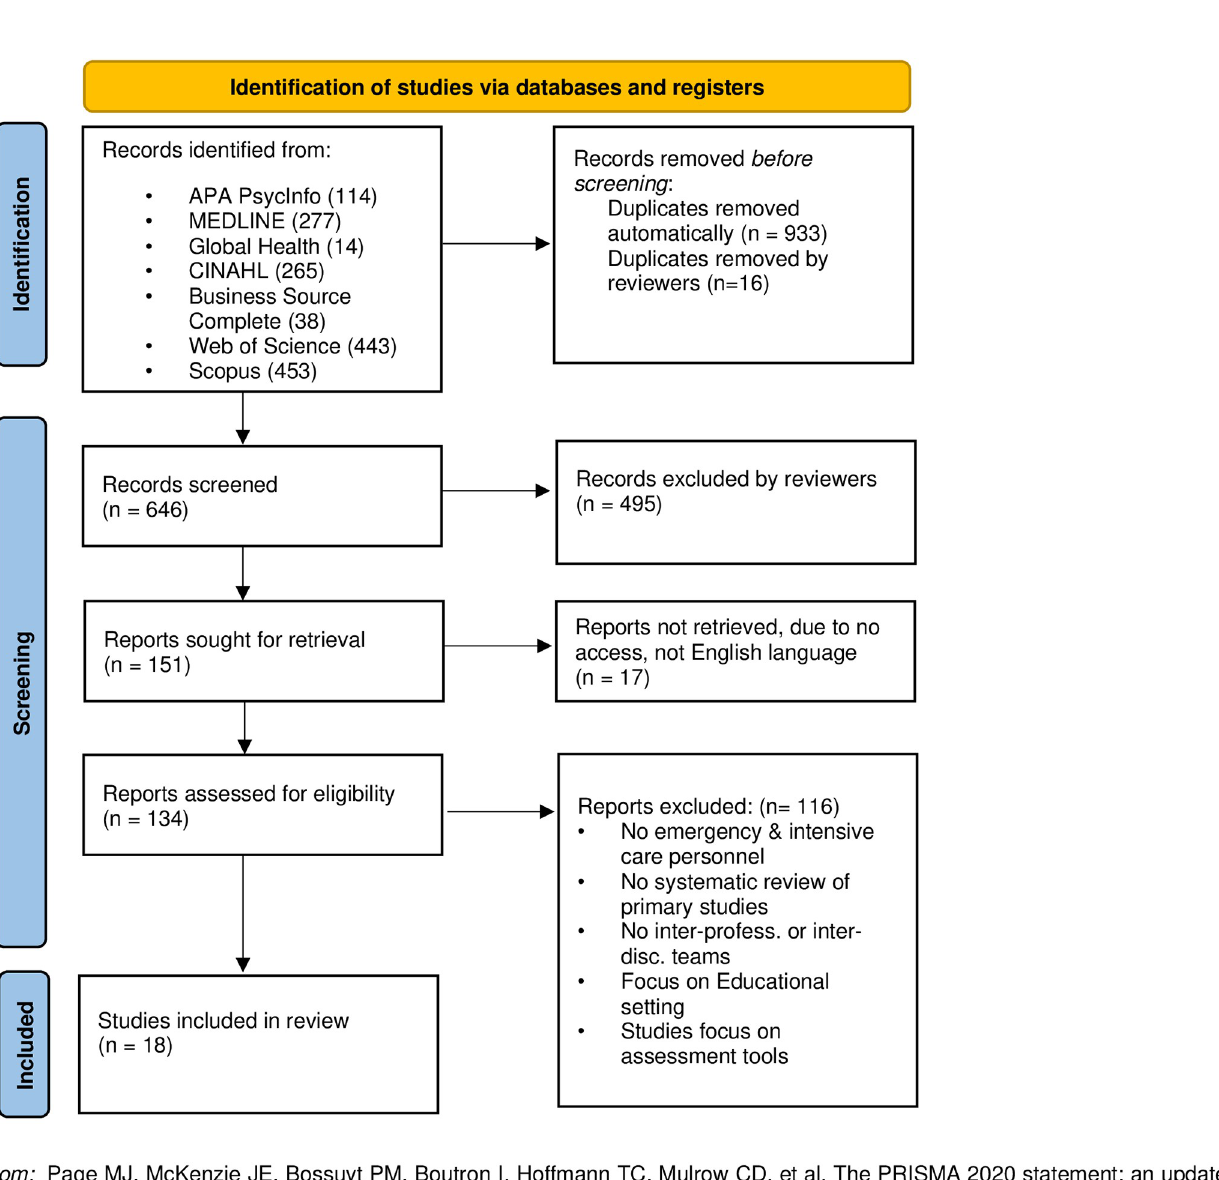
Fig 1. PRISMA flow chart. The PRIMSA diagram details our search and selection process applied during the review.